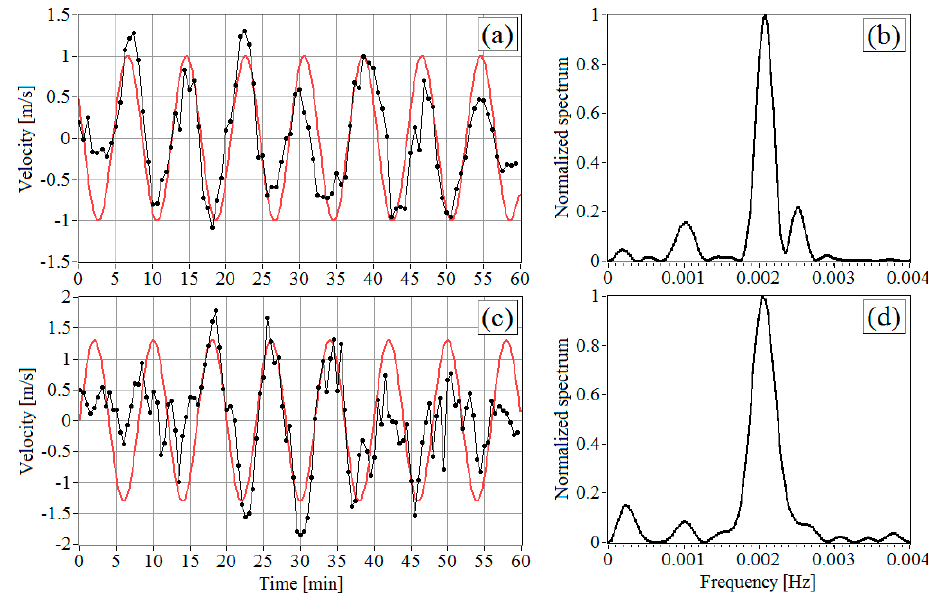
Figure 14. Time series ( a , c ) of the oscillating components of the vertical wind velocity at a height of 271 m above the Baikal level ( a ) and the horizontal wind component at a height of 10 m above the Baikal level ( c ) starting from 02:30 LT on 23 August 2018 and their normalized power spectra ( b , d ). Circles connected by lines are the oscillating wind components obtained from the data of the lidar ( a , b ) and the sonic anemometer ( c , d ). Red curves are the results of the fitting of the harmonic dependence to the corresponding measured time dependence of the velocity.